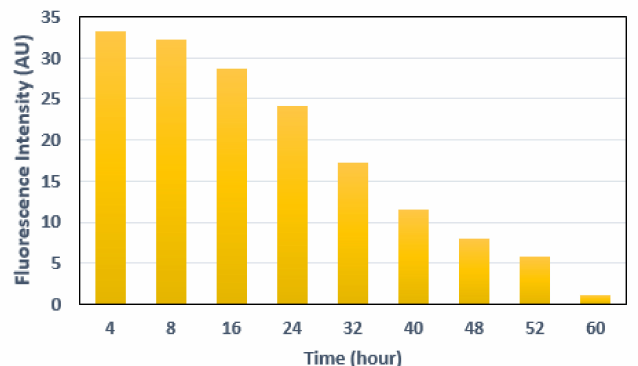
Figure 10. Fluorescence intensity measured at di ff erent time-points from the initial application of fluorescein.